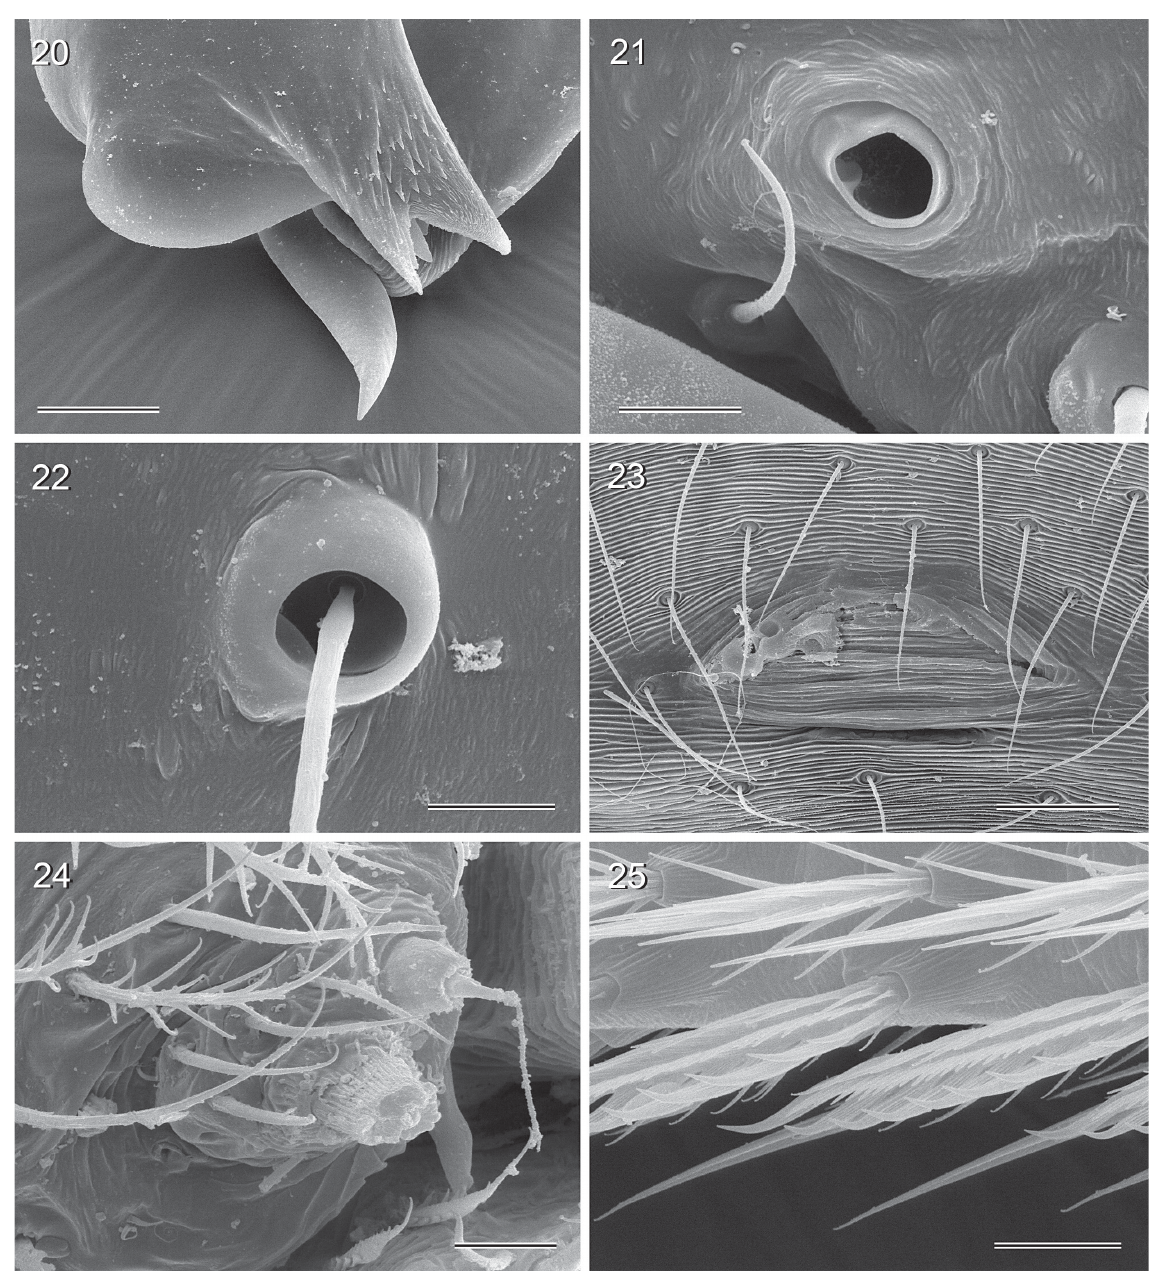
Figs 20–25. Hantu kapit gen. et sp. nov., ZFMK Ar 15069. 20 . Tip of right procursus, retrolateral view. 21 . Male palpal tarsal organ. 22 . Trichobothrium base on male palpal tibia. 23 . Male gonopore. 24 . Male ALS. 25 . Comb-hairs on male tarsus 4. Scale lines: 8 µm (21); 10 µm (22, 24–25); 40 µm (20,